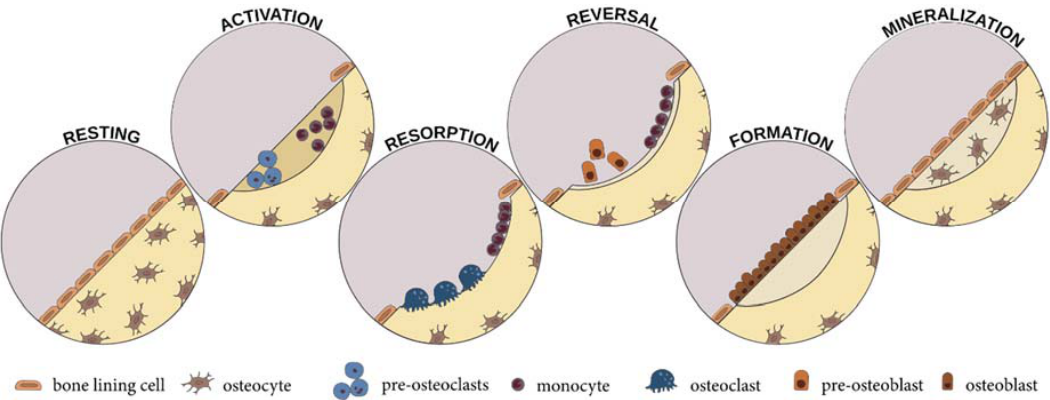
Figure 1. The five stages of bone remodeling.